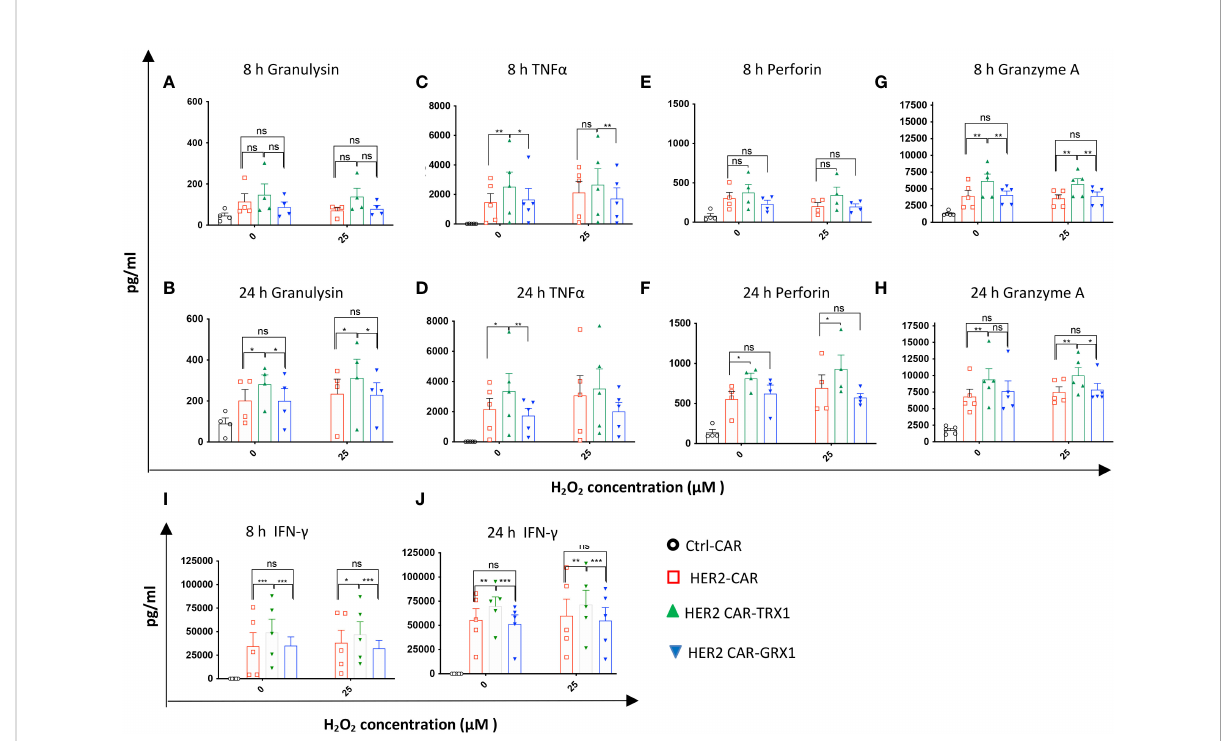
FIGURE 4 Release of effector cytokines under pro-oxidative conditions. After coculture of CAR T cells with SKBR3 cells (8 and 24 h), supernatants were collected and evaluated using the human CD8/NK panel 13-plex (A – H) and IFN- g ELISA assay (I, J) . Cytokines differentially released by HER2-CAR T and HER2- CAR-TRX1 T cells are shown. Release of granulysin after (A) 8 h, (B) 24 h; TNF a after (C) 8 h, (D) 24 h; Perforin after (E) 8 h, (F) 24 h; and granzyme A after (G) 8 h, (H) 24 h. (I, J) Release of IFN- g after (I) 8 and (J) 24 h coculture. Data represent mean ± SEM (n ≥ 3; *p < 0.05, **p < 0.01, *** p < 0.001, ns = non-signi fi